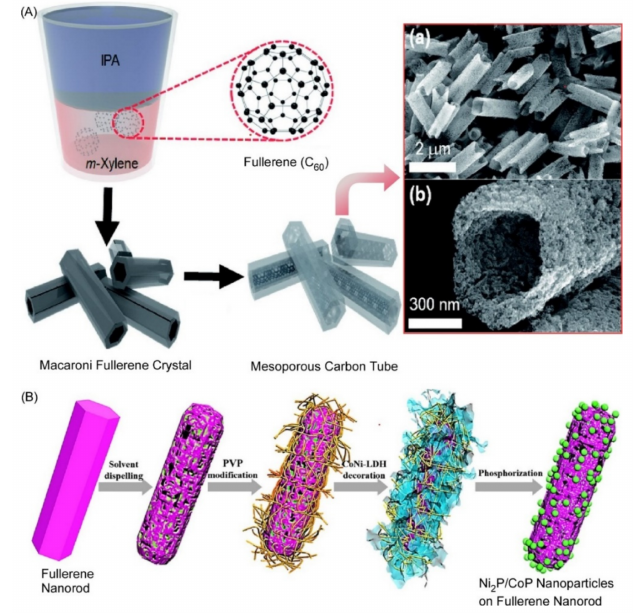
Figure 12. Modified fullerene crystals: ( A ) self-assembled macaroni fullerene C 60 crystals and heat-treating conversion to mesoporous carbons tubes; and ( B ) hybrid nanostructures of Ni 2 P/CoP nanoparticles supported on porous fullerene nanorods as bifunctional electrocatalysts. Reprinted with permission from [164]. Copyright 2021, Chemical Society of Japan. Reprinted with permission from [165]. Copyright 2021, American Chemical